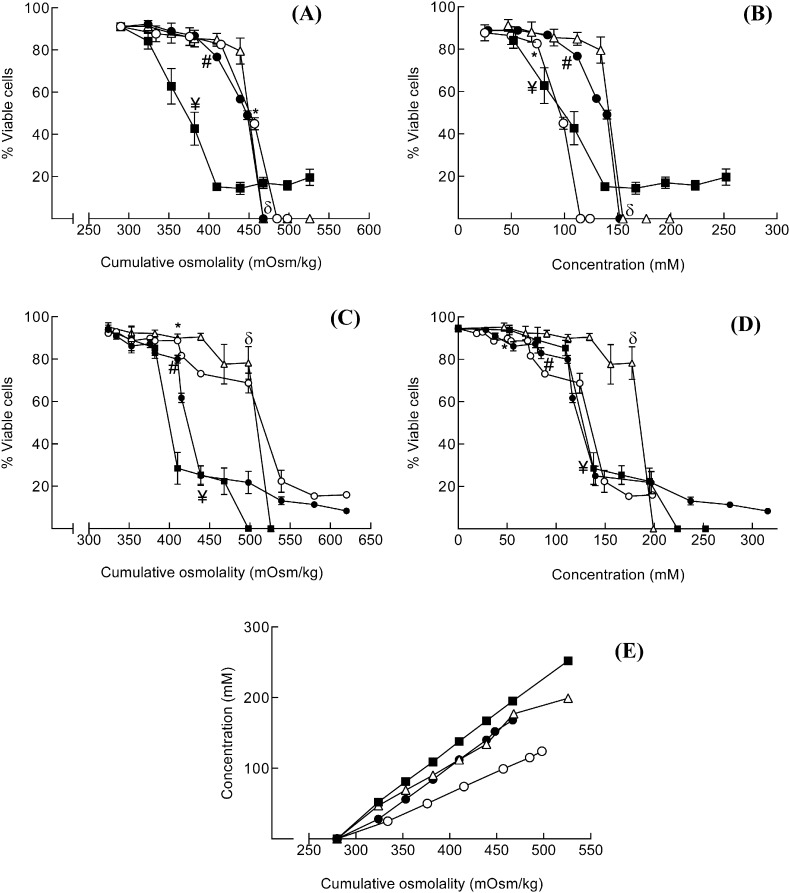
Effect of changes in osmolality on THP-1 cell or fibroblast viability: comparisons of different saltsTHP-1 cells were seeded into 24-well plates at 106 cells/mL in serum free RPMI media (A, B) or human primary fibroblasts were seeded at 2 × 105 cells/mL in complete DMEM medium in flat-bottomed 24 well plates for 6 h at 37 °C (C, D). Cells were cultured in serum free media for 24 h at 37 °C with varying concentrations of NaCl (○), Arg·Glu (●), Arg·HCl (■) and NaGlu (∆) spanning a range of osmolalities from 280 to 525 mOsm/kg (A) or from 280 to 625 mOsm/kg (C) and a range of concentrations from 0 to 250 mM (B) or from 0 to 325 mM (D). Control cells were cultured with medium alone (280 mOsm/kg). Following culture, fibroblasts were trypsinized and THP-1 and fibrobalsts were harvested and cell viability was determined using PI. Cells (10,000) were analyzed by flow cytometry using a FACSCalibur flow cytometer for PI staining (FL2 channel; viability) against forward scatter (FSC; size). Data are displayed as % cell viability for n = 3–6 experiments (mean and SE) versus excipient with respect to cumulative osmolality (A, C) and the concentrations of each excipient required to achieve the required osmolality (B, D). The statistical significance of differences between cells cultured in medium alone (isotonicity) and cells treated with various concentrations of salts was assessed by one way ANOVA (p < 0.05; * = NaCl, # = Arg·Glu, ¥ = Arg·HCl, δ = NaGlu). For clarity of presentation, only the first concentration of each salt preparation at which there was a significant loss of cell viability is illustrated. The relationship between each individual salt concentration as formulated in RPMI media and cumulative osmolality as measured using an osmometer is illustrated in (E).